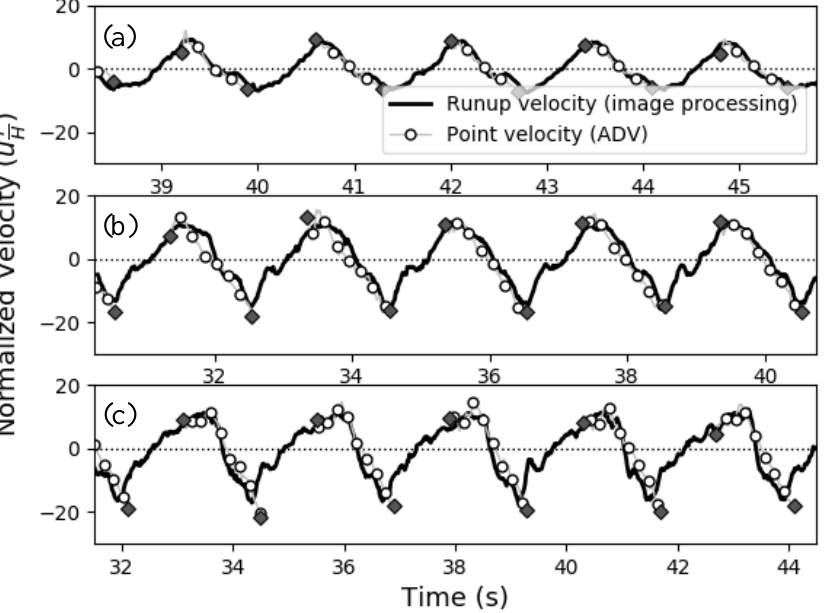
Figure 7. Comparison of the computed runup velocity and the ADV point velocity measurement time-series for the wave periods ( a ) T = 1.4 s, ( b ) T = 2.0 s, and ( c ) T = 2.4 s .